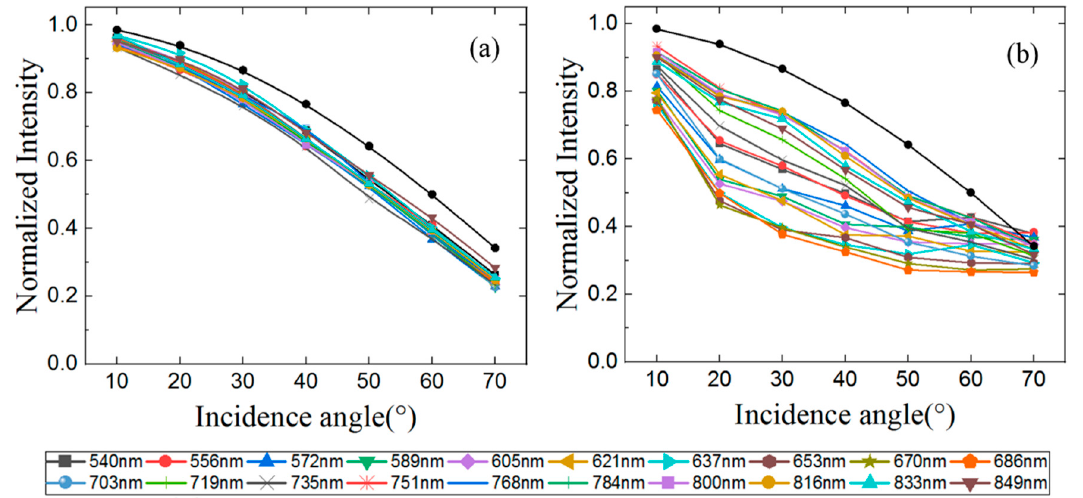
Figure 6. Backscattered intensities of the twenty wavelengths are normalized to 1 at 0°. ( a ) Normalized intensities of the 99% standard reflectance panel; ( b ) normalized intensities of a leaf sample. Lambertian cosine law is depicted in black.